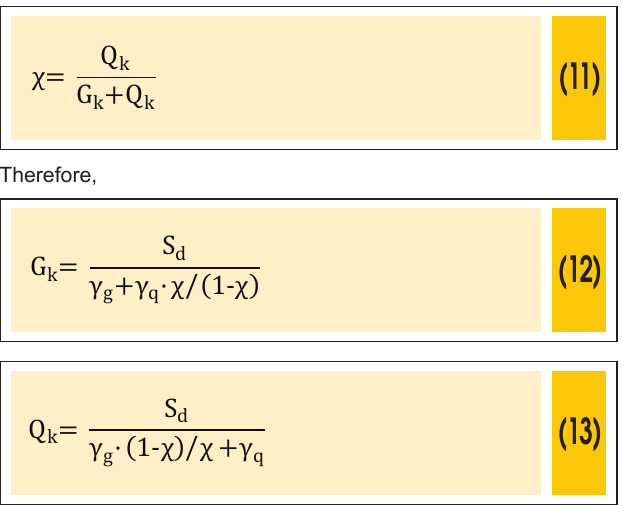
Evaluation of design resistance